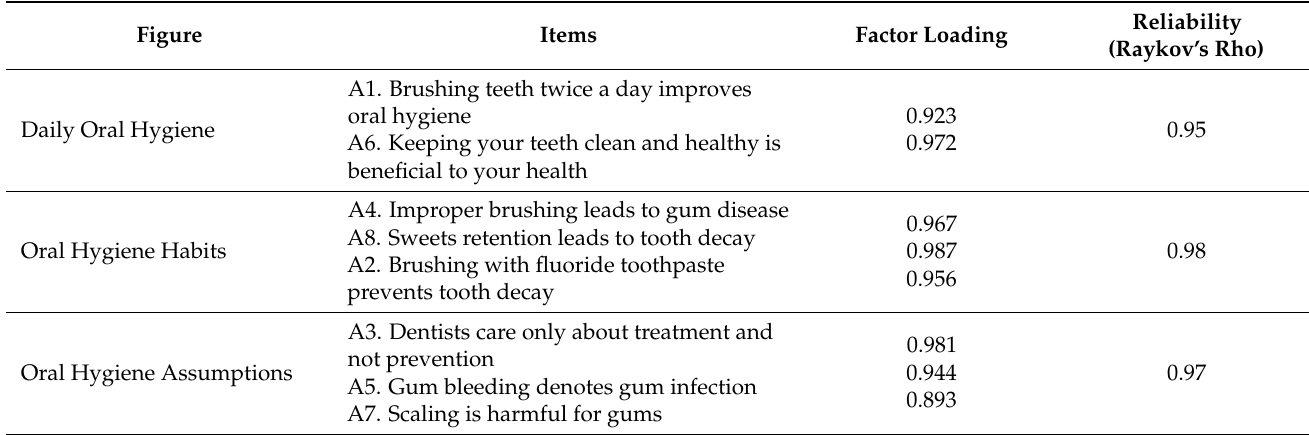
Table 5. CFA for the attitude domain. Items Factor